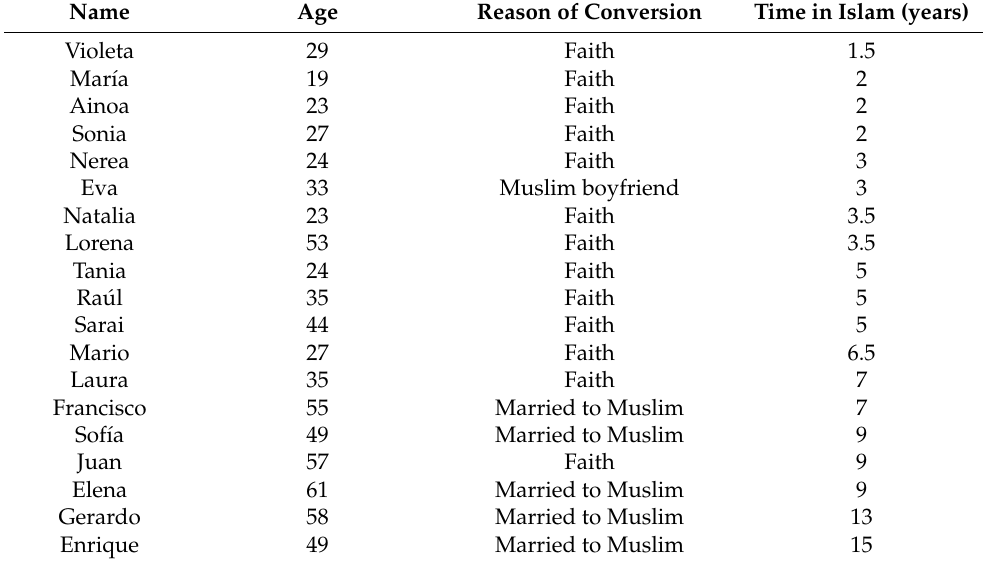
Table 1. List of